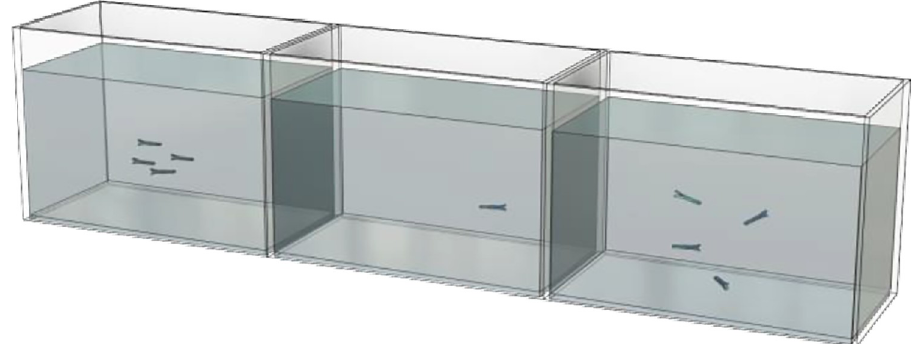
Fig 1. Experimental apparatus. Illustrative example with the subject in the center tank to test preference between an established shoal on the right and a newly-formed shoal on the left. The apparatus consists of three identical 18.9L (5.5 gal.) glass aquaria (each 20.3 cm wide × 25.4 cm high × 40.6 cm long; total width = 121.8 cm) filled with water to a depth of 21